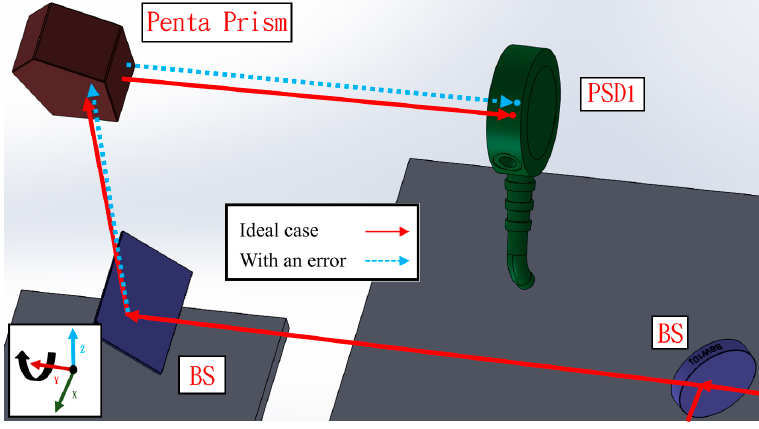
Figure 3. Light path with roll error.